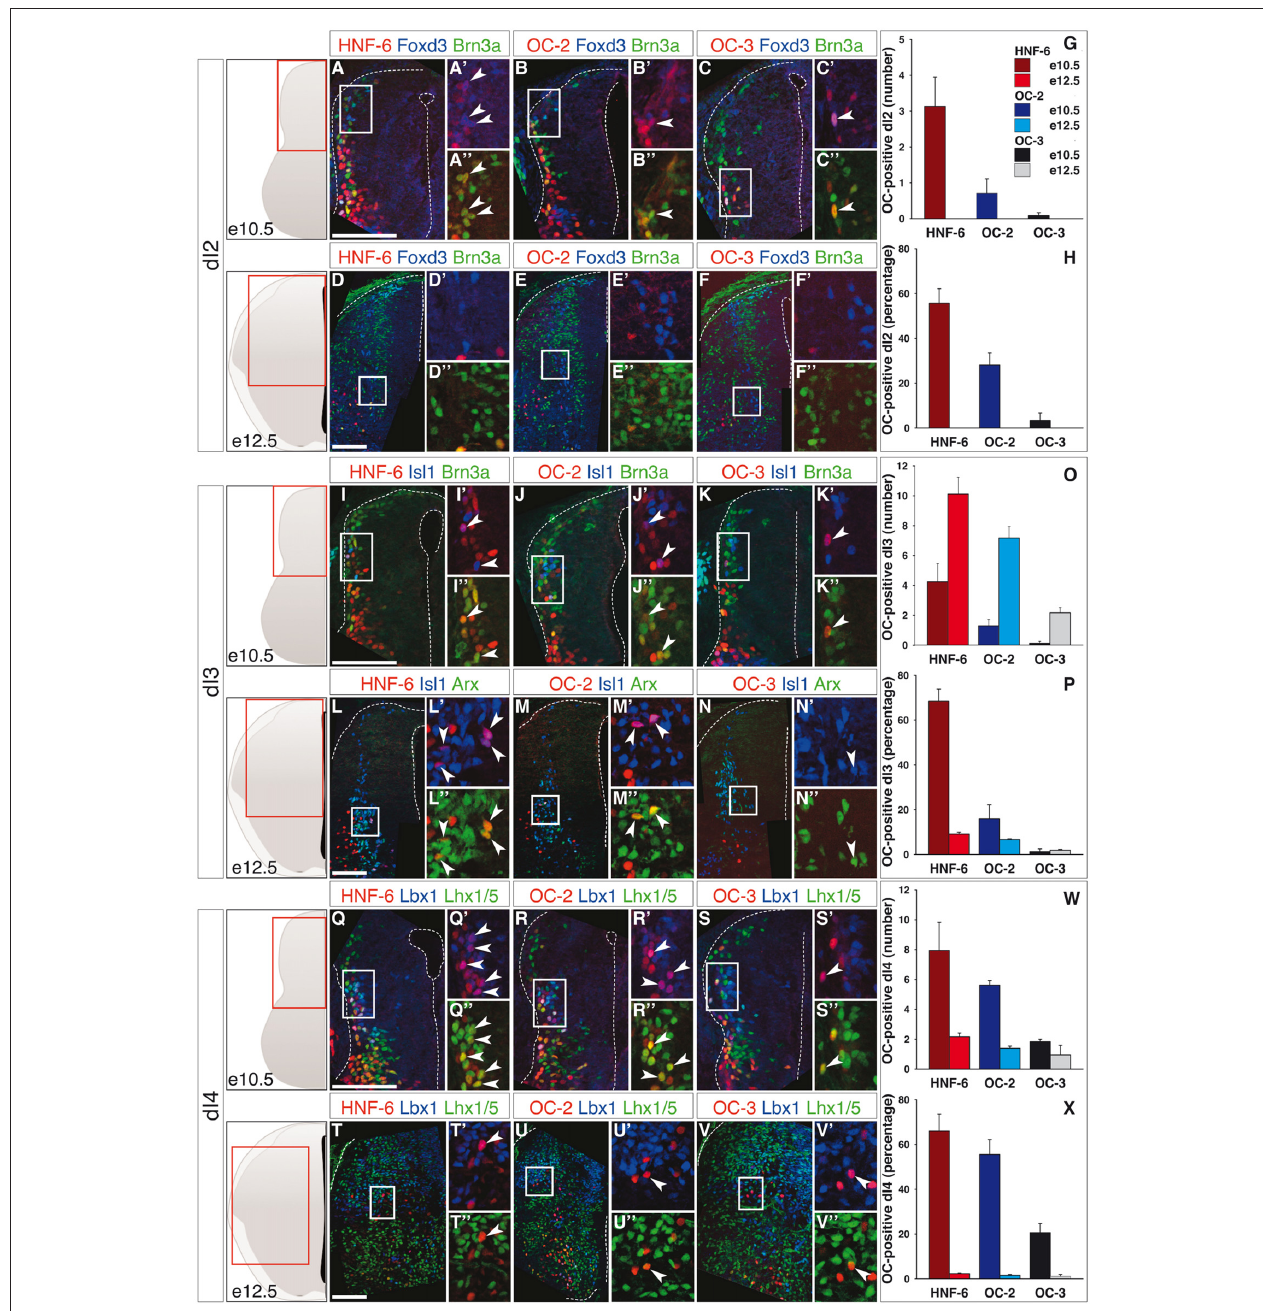
FIGURE 1 | Onecut (OC) factors are differentially and dynamically distributed in dI2 to dI4 populations. (A–F) Immunodetection of HNF-6, OC-2 or OC-3 (red) in Foxd3 + (blue) Brn3a + (green) dI2 neurons on transverse sections of thoracic spinal cord at e10.5 (A–C) and e12.5 (D–F) . HNF-6 (A–A”) , OC-2 (B–B”) and OC-3 (C–C”) are visible in a few dI2 cells at e10.5 whereas they are not detected at e12.5 (D–F”) . The number (G) and percentage (H) of OC-positive dI2 neurons per hemisection were quantified accordingly. (I–N) Immunodetection of HNF-6, OC-2 or OC-3 (red) in Isl1 + (blue) Brn3a + /Arx + (green) dI3 neurons on transverse sections of thoracic spinal cord at e10.5 (I–K) and e12.5 (L–N) demonstrates that OC factors are present in dI3 from e10.5 to e12.5 with a slight predominance of HNF-6 (I,L) compared to OC-2 (J,M) or OC-3 (K,N) . Despite an increase in the number of OC + dI3 neurons from e10.5 to e12.5 (O) , the percentage of dI3 neurons containing OC factors (P) is reduced at embryonic stage e12.5. (Q–V) Immunodetection of HNF-6, OC-2 or OC-3 (red) in Lbx1 + (blue) Lhx1/5 + (green) dI4 neurons on transverse sections of thoracic spinal cord at e10.5 (Q–S) and e12.5 (T–V) shows that OC factors are present in early dI4 neurons, HNF-6 (Q–Q”) being the most represented. At e12.5, HNF-6 (T–T”) and OC-2 (U–U”) are still detected in a few dI4 neurons while OC3 (V–V”) is barely detectable. Quantifications at embryonic stages e10.5 and e12.5 show that number (W) and percentage (X) of OC-positive dI4 neurons decrease from e10.5 to e12.5. The pictures show left hemisections as indicated to the left. Dashed lines delineate the spinal cord and the lumen of the ventricle. Insets are magnified views of boxed regions. Arrowheads point to double-labeled cells. Mean values ± SEM, n ≥ 3. Scale bars = 100 µ m.